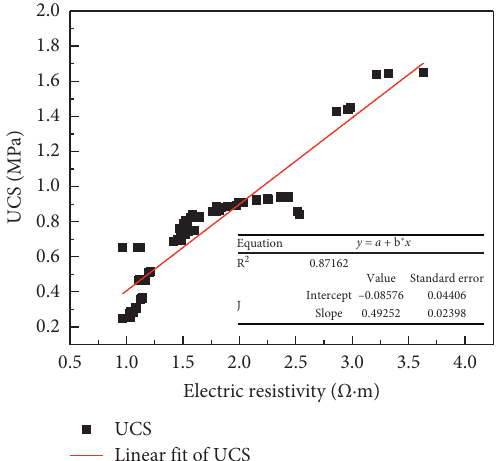
Figure 14: The correlation between the electrical resistivity and UCS of the